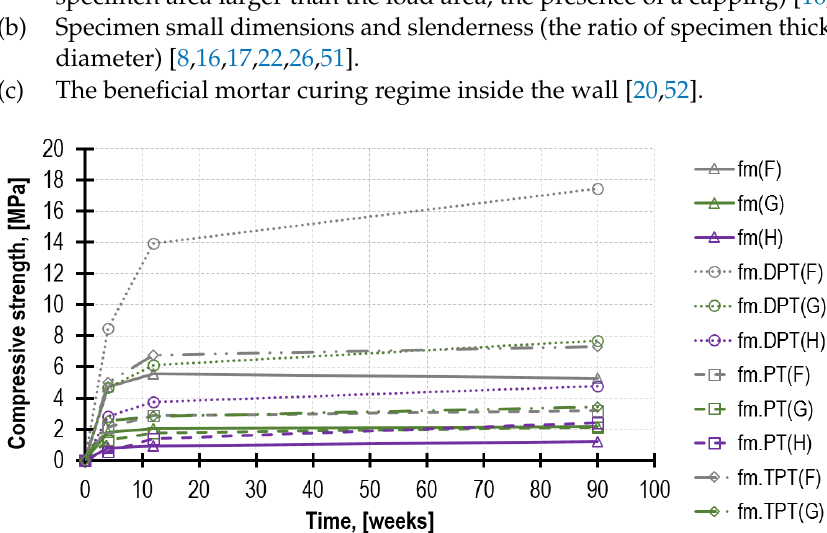
Figure 16. Mortar strength development in time according to different testing methods. The respective test types are marked with a given line style, and the respective mortar types are marked with a given color.